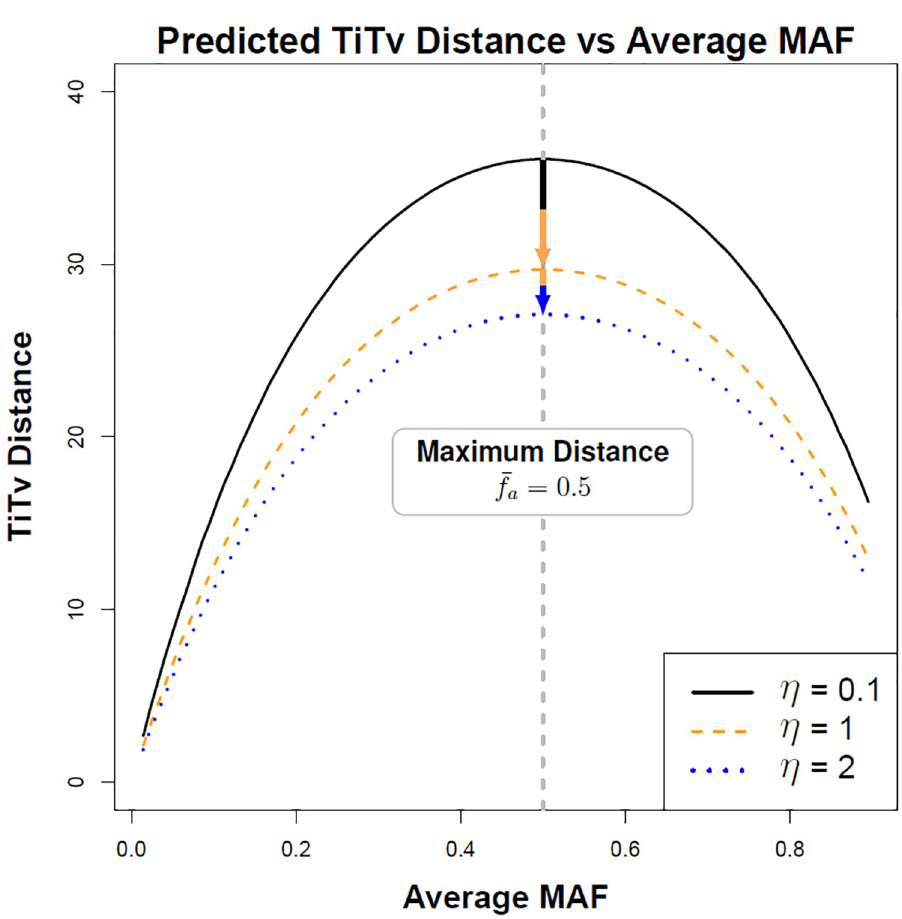
Fig 6. Predicted average TiTv distance as a function of average minor allele frequency � f probabilities f a are drawn from a sliding window interval from 0.01 to 0.9 in increments of about 0.009 and m = p = 100. For η = 0.1, where η is the Ti/Tv ratio given by Eq 126, Tv is ten times more likely than Ti and results in larger distance. Increasing to η = 1, Tv and Ti are equally likely and the distance is lower. In line with real data for η = 2, Tv is half as likely as Ti so the distances are relatively